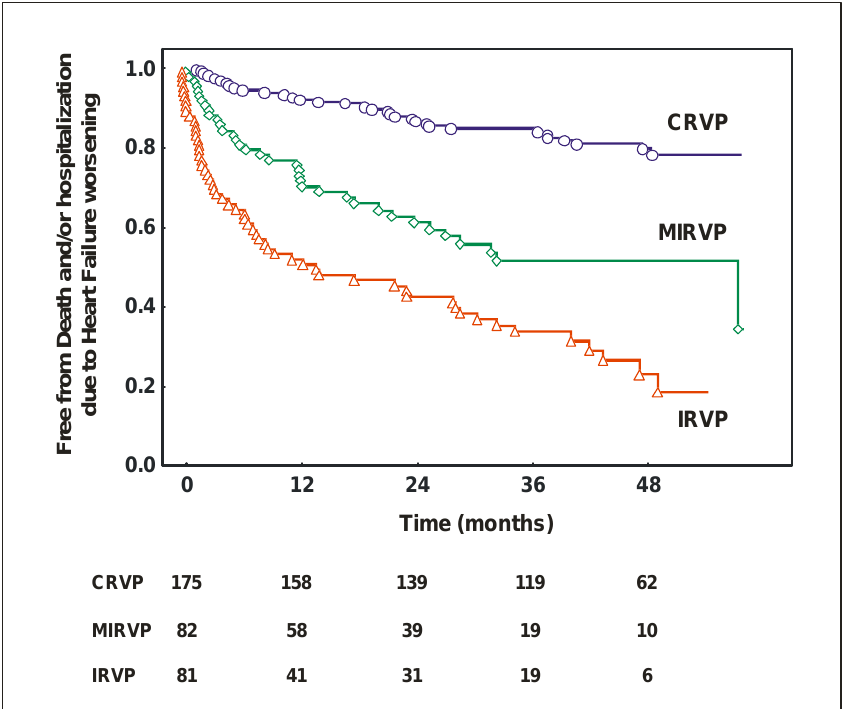
Figure 2. Kaplan Meier curves for the occurrence of death and/or hospitalization due to heart failure worsening in patients with continuous renal venous flow pattern (CRVP, i.e., Pattern A or B), mild intermittent/reversal renal venous flow pattern (MIRVP, i.e., Pattern C) and intermittent/reversal renal venous flow pattern (IRVP, i.e., Pattern D or E).